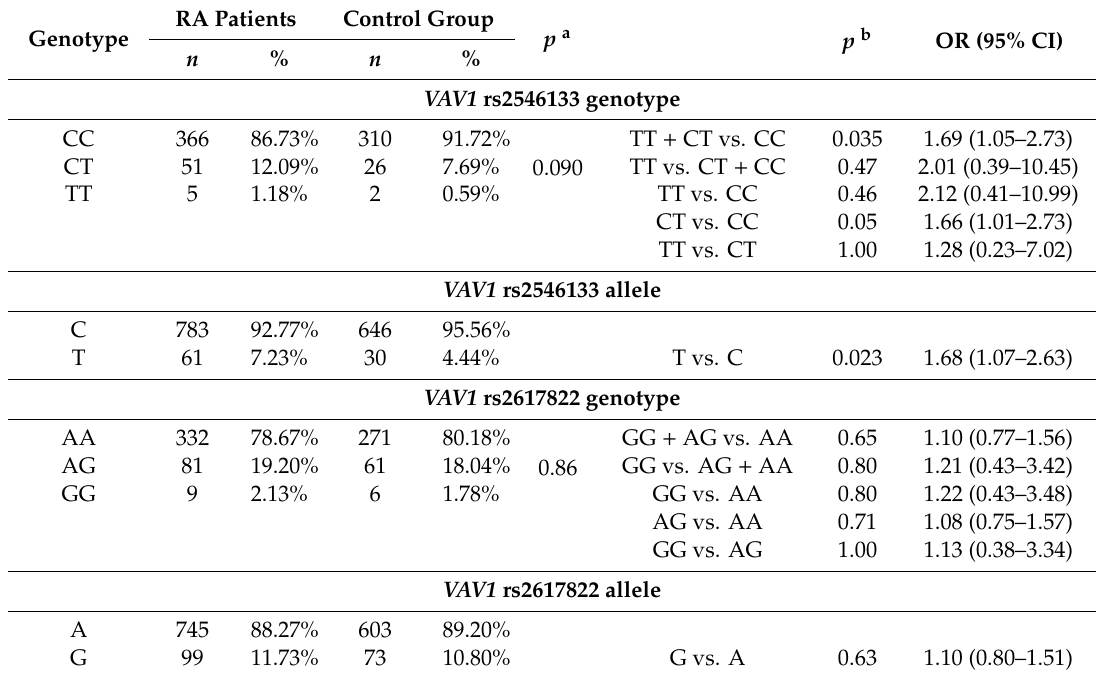
Table 1. The distribution of VAV1 rs2546133 and rs2617822 genotypes in rheumatoid arthritis (RA) patients and the control group.